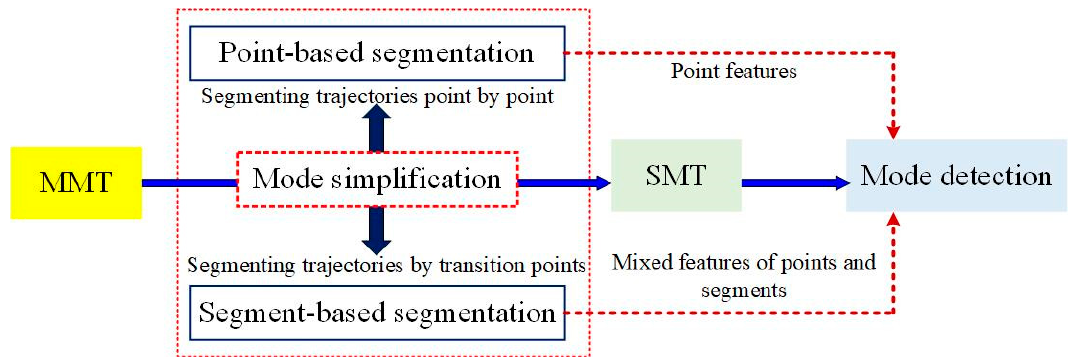
Figure 5. The mechanism of MMT classification based on transportation mode.